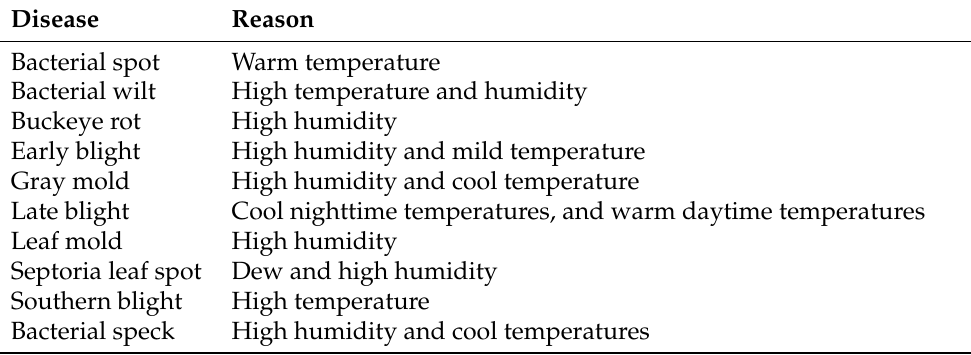
Table 3. Tomato crop disease, majorly caused due to variation of temperature and humidity